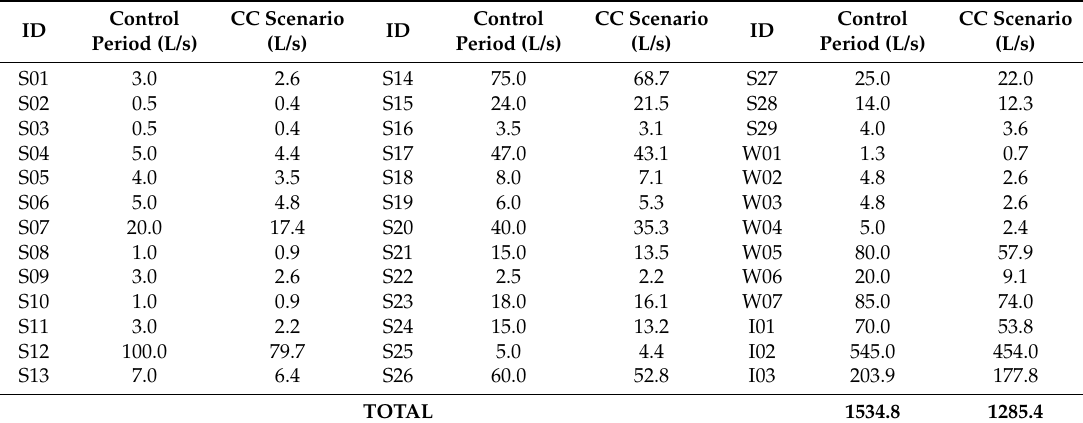
Table 3. Projected changes in the available flow of each of the 39 source